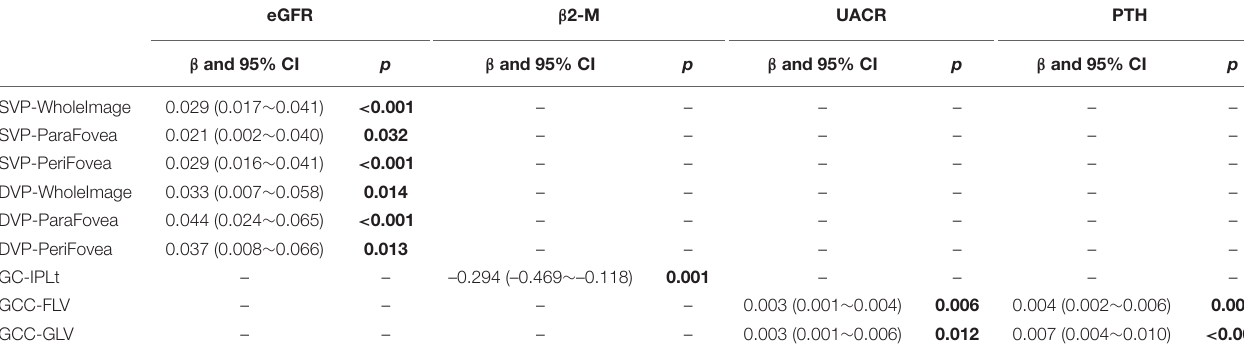
TABLE 5 | Stepwise multivariate linear regression between OCTA parameters and CKD-related parameters (115 CKD patients). eGFR β 2-M